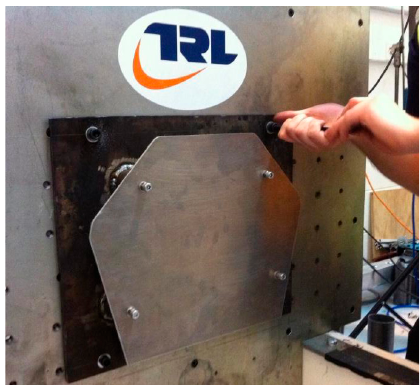
Figure 8. Nose cone mounting plate—showing 50 mm offset [18].